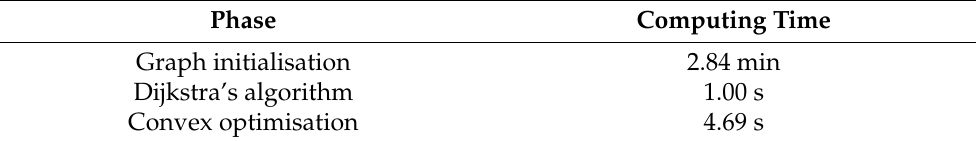
Table 4. Average computing time for various phases of the combined